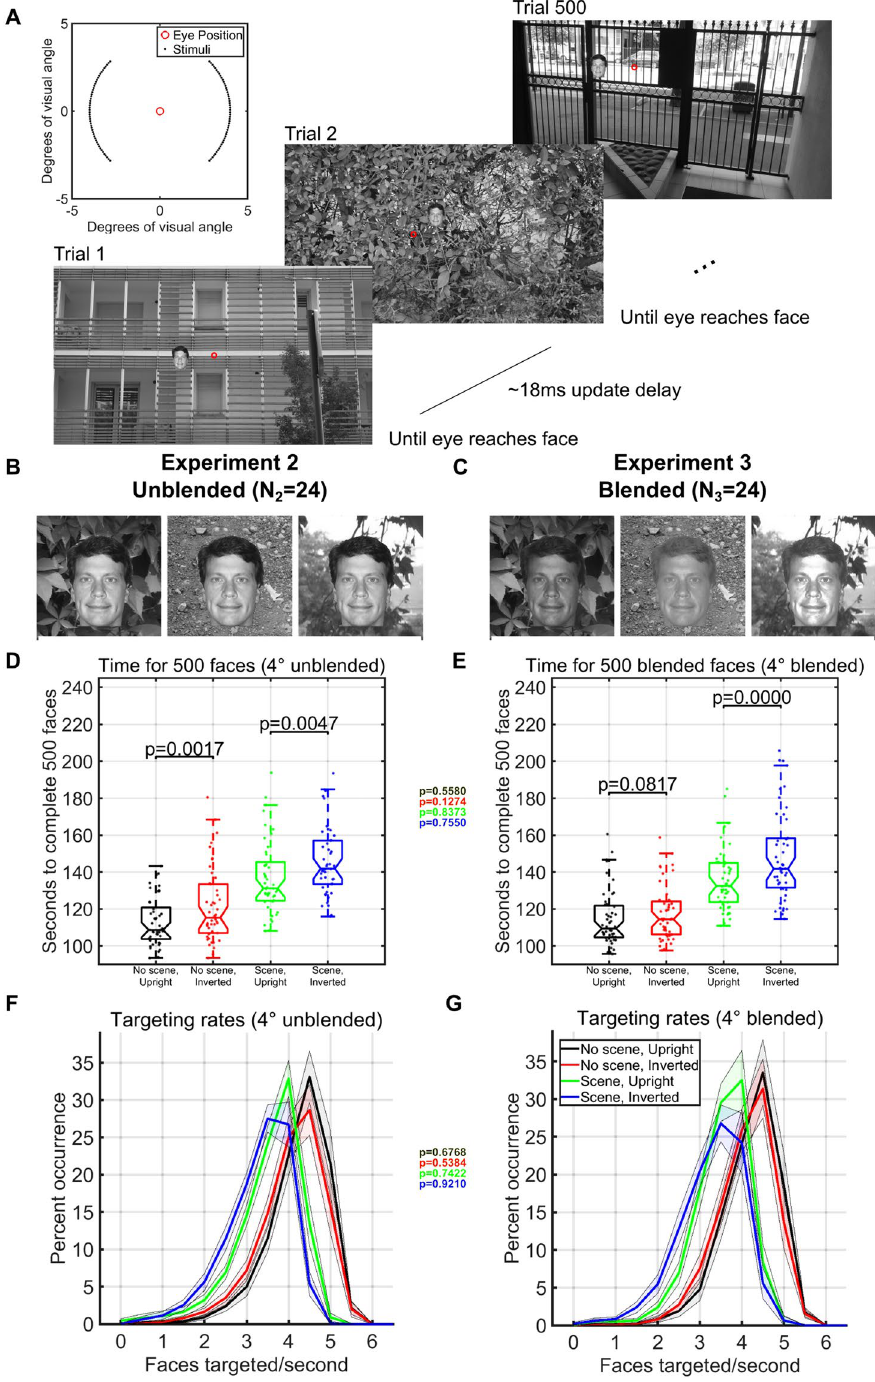
Figure 3. Paradigm and timing results in limited eccentricities and polar angles (Experiments 2 and 3). ( A ) One block of 500 trials in the gaze-contingent continuous face detection paradigm with upright faces pasted on a background. The red circle represents the hypothetical gaze location and did not appear during the experiment. The subject had to localize the face with their gaze to move on to the next trial. Locations of the 3° faces were within 4° eccentricity of the location of the face in the previous trial and appeared at polar angles between 0°–45°, 135°–235°, 315°–360° (see inset at upper left). Faces shown are for illustration, but all experiments used different faces in each trial of each block. ( B ) Examples of how unblended faces would appear on different backgrounds in Experiment 2 (N 2 = 24 subjects). ( C ) Examples of how blended faces would appear on different backgrounds in Experiment 3 (N 3 = 24 subjects). ( D , E ) Boxplots of the number of seconds required, including blinks and all eye-movement times, to complete 500 3° faces at 4° eccentricities in each condition over 24 subjects in Experiment 2 ( D ) and Experiment 3 ( E ). Individual dots are the time taken to complete a single counterbalanced block of 500 faces in each particular condition for each